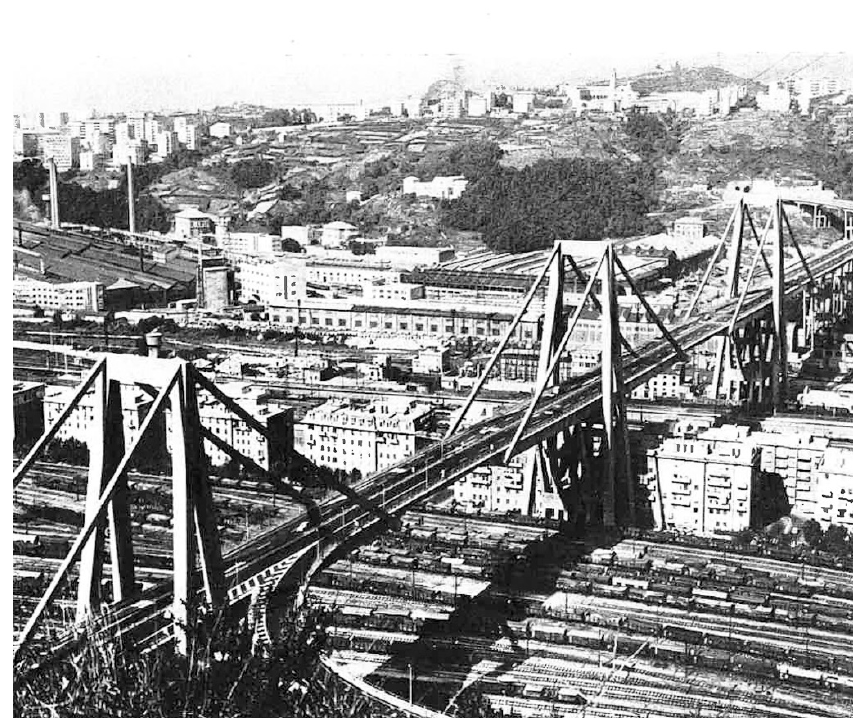
Figure 1. View of Polcevera Viaduct from the north-east (Morandi, 1968).